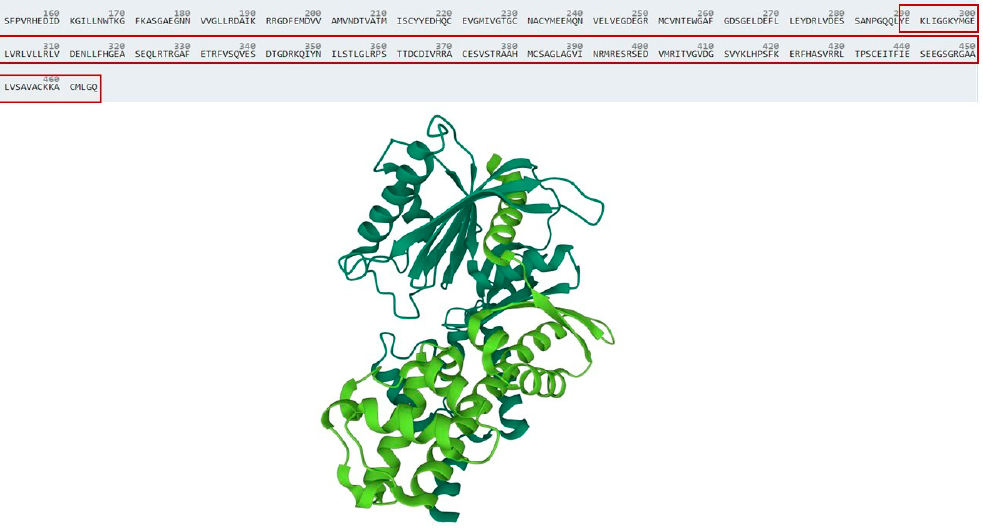
Figure 4. Overall structure of Glucokinase. Figure shows the structure of GCK (Hexokinase-4) according to protein databank (PDB) identity 1V4S. Protein region involved in the rearrangement is highlighted in the red box and showed in light green.